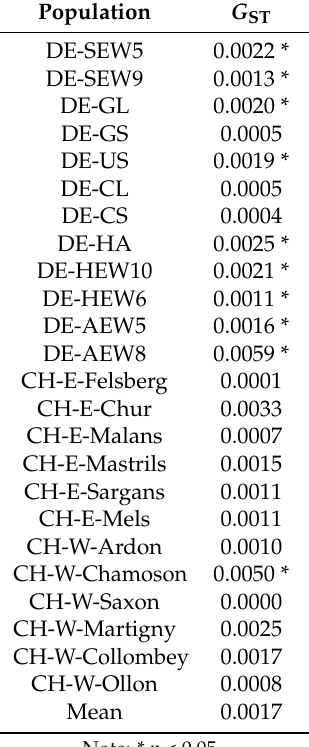
Table 4. Pairwise G ST values between adult and seedling cohorts based on